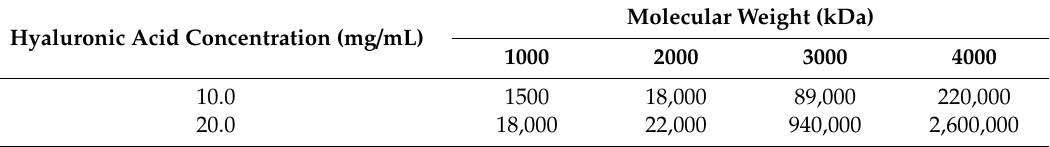
Figure 3. The dependency of the zero shear viscosity of hyaluronic acid on concentration for various molecular weights ( a ); on the [biopolymer concentration × molecular weight] ( b ). Reproduced from [49], with permission from John Wiley and Sons, 2020. Table 2. Viscosity (mPa · s) of hyaluronic acid solutions with di ff erent concentrations and molecular weights. Adapted from [50], with permission from Taylor & Francis, 2020.